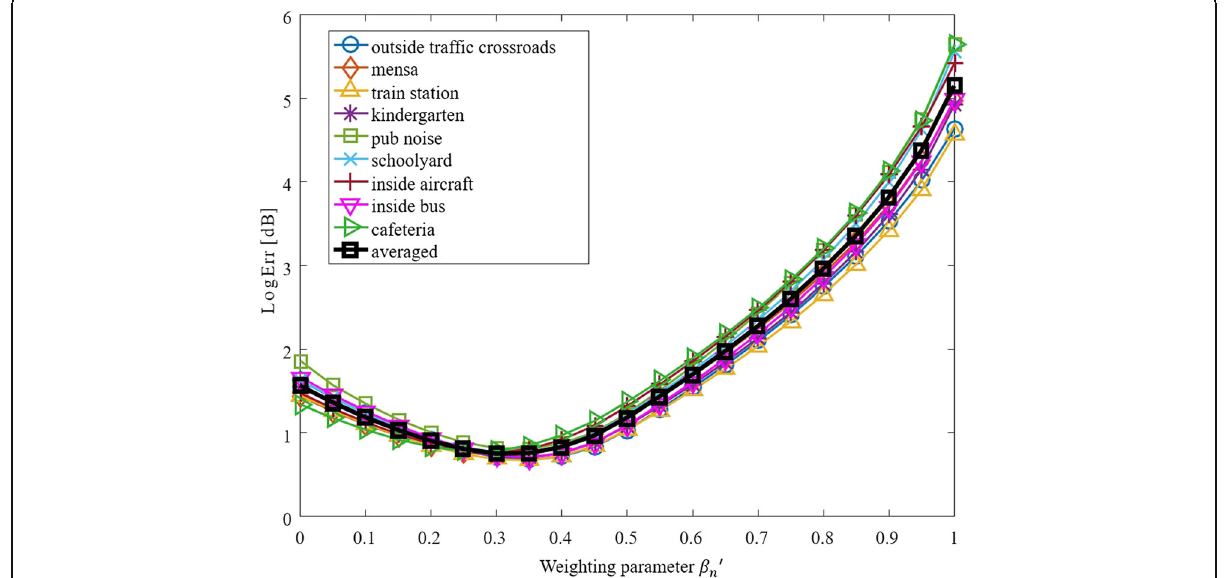
Fig. 5 LogErr according to the weighting parameter for the eigenvalue